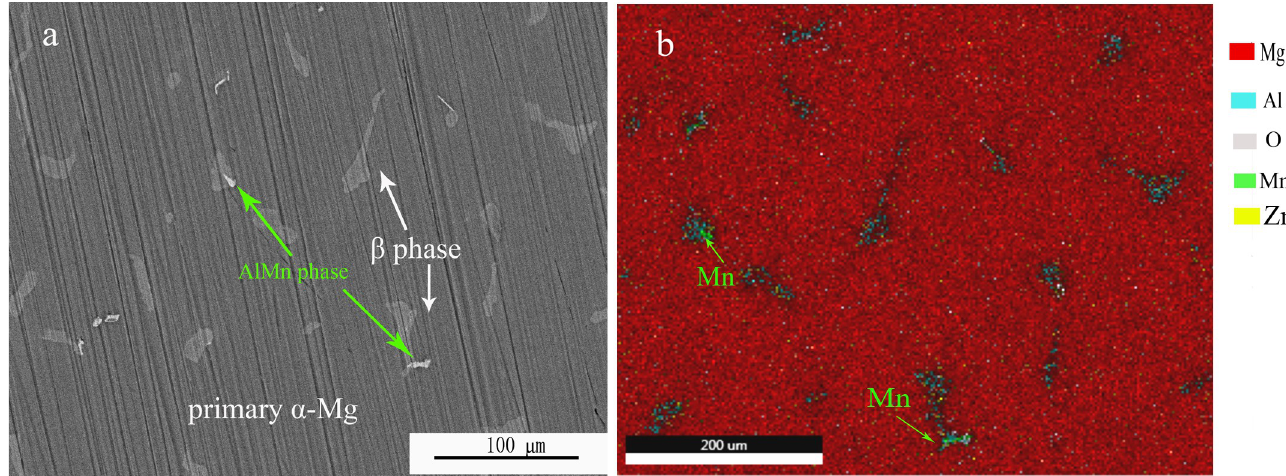
Fig 3. SEM (a) and EDS (b) images of AZ91D magnesium alloy before corrosion exposure.